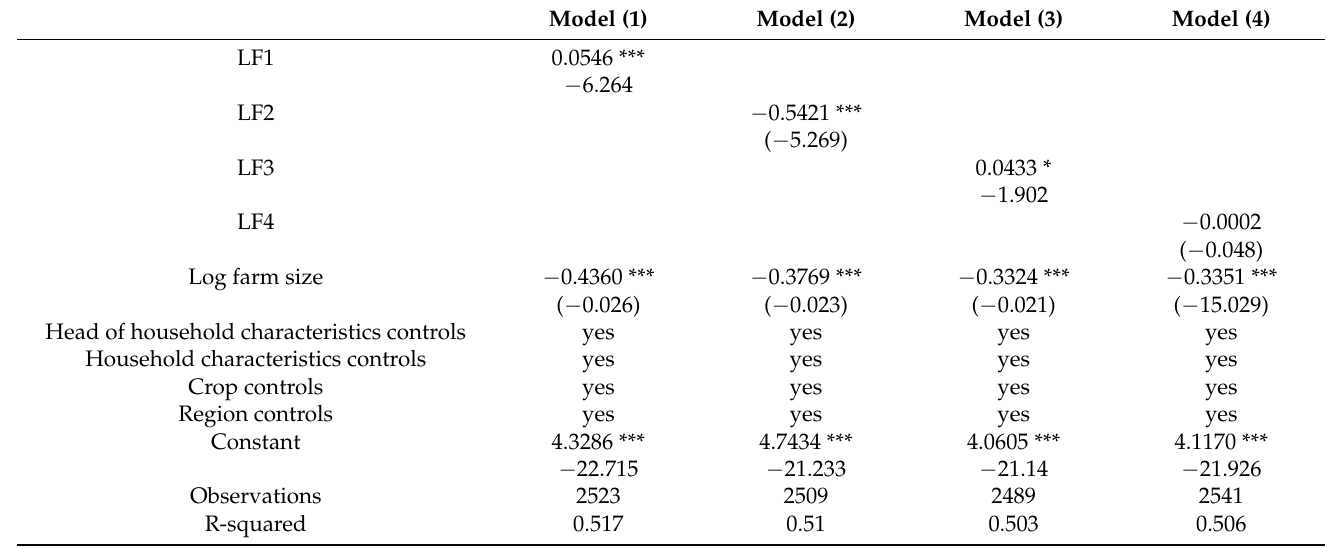
Table 4. Results of LF on labour